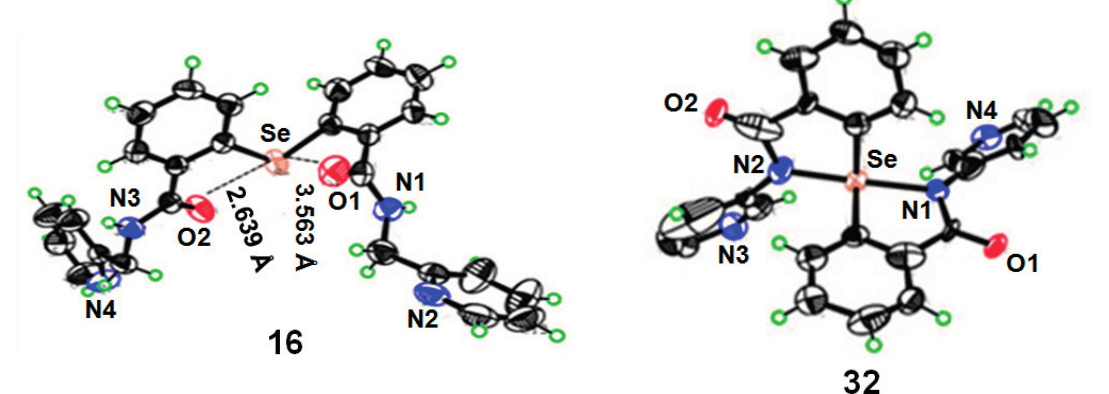
Figure 2. Single crystal X-ray structures of compounds 16 and 32 with atom labeling scheme at 50%